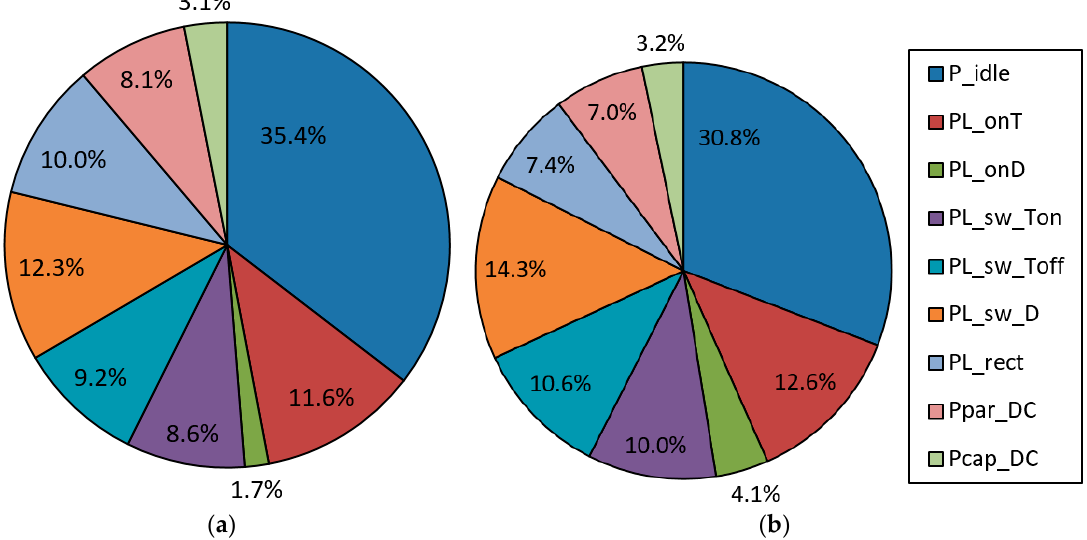
Figure 13 Figure 13. CDM Loss components in mode 4 for different motor types: ( a ) IM (total loss value 39.5 W); ( b ) SynRM (total loss value 45.4 W).